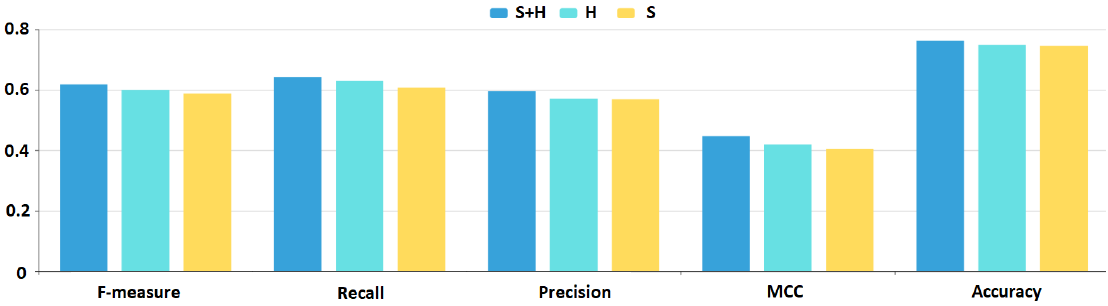
Figure 5. Deep neural network.